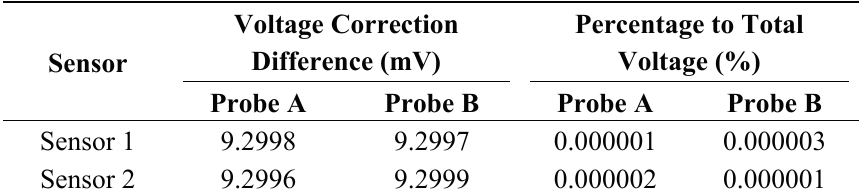
Table 1. Correction data of micro voltage sensor.